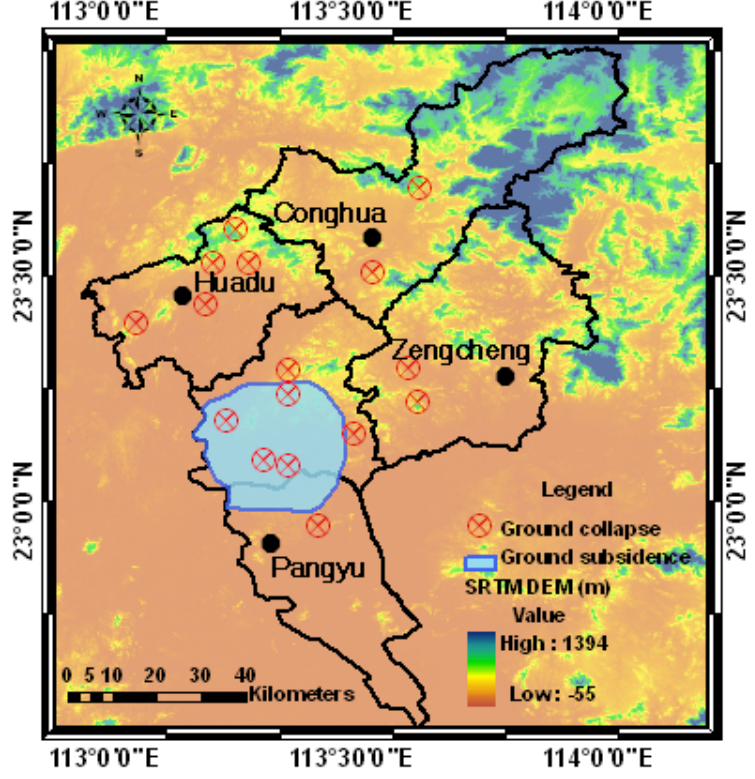
Figure 2. Distribution of ground collapse and ground subsidence in Guangzhou City (partially referred to